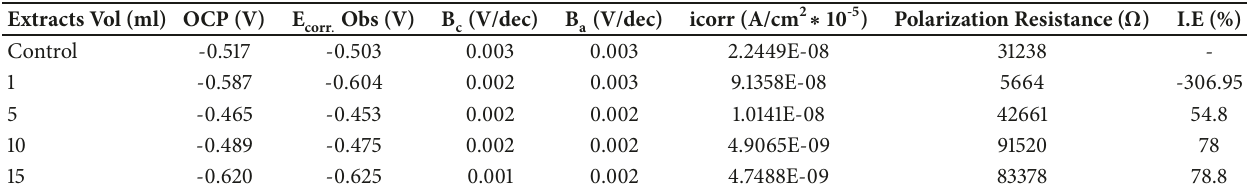
Table 4: Electrochemical parameters obtained from the Tafel plots for cathodic protection and different volumes (ml) of oil extract of Monodora myristica for steel with zinc in seawater environment.